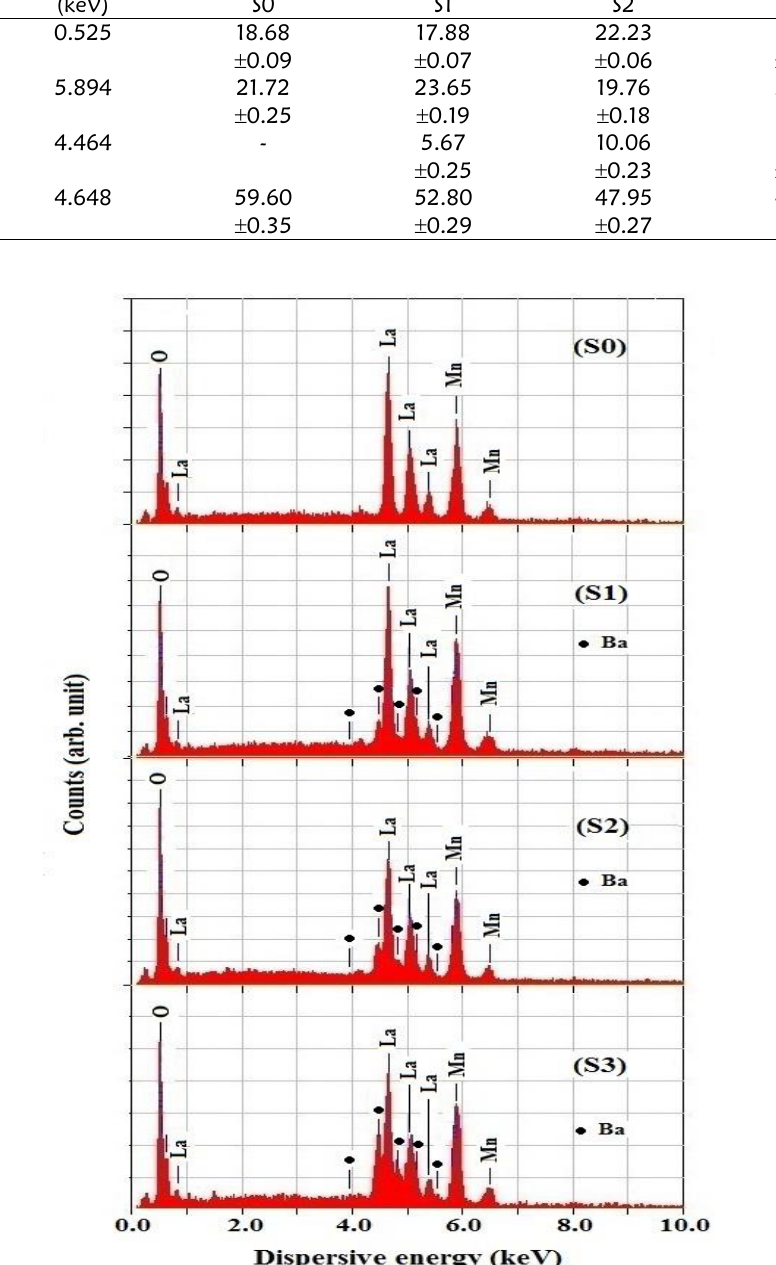
Figure 2. The EDS spectrum of LaMnO 3 (S0), La 0.9 Ba 0.1 MnO 3 (S1), La 0.8 Ba 0.2 MnO 3 (S2), and La 0.7 Ba 0.3 MnO 3